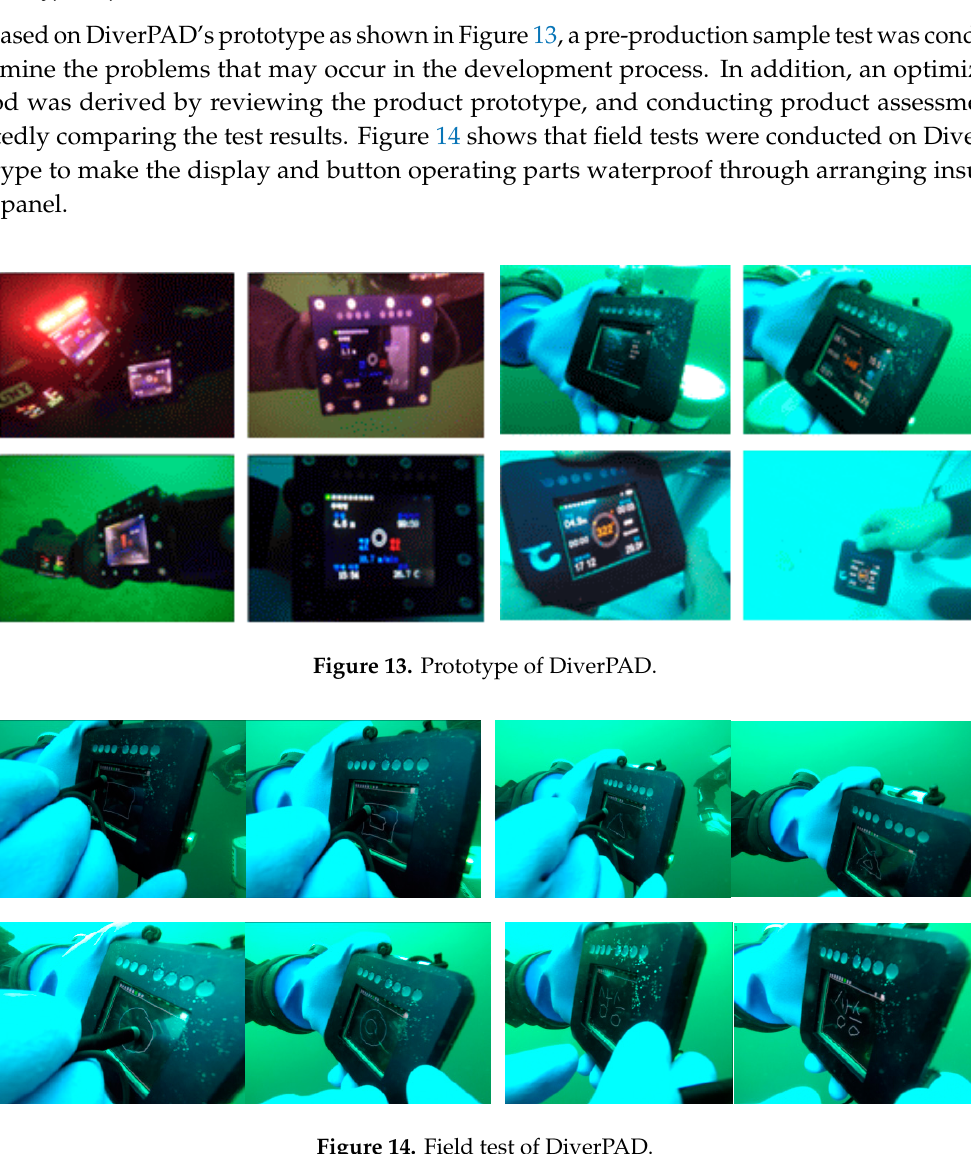
Figure 14. Field test of DiverPAD.